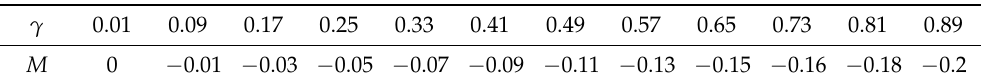
Table 12. Values of the medial correlation of the TGCC copula for θ = ( − γ ,1/ values of γ , belonging to Configuration